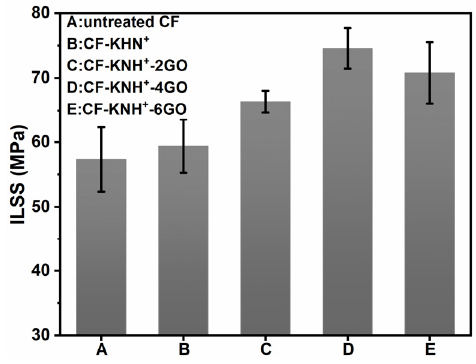
Figure 9. ILSS of GO/CF multiscale composites.